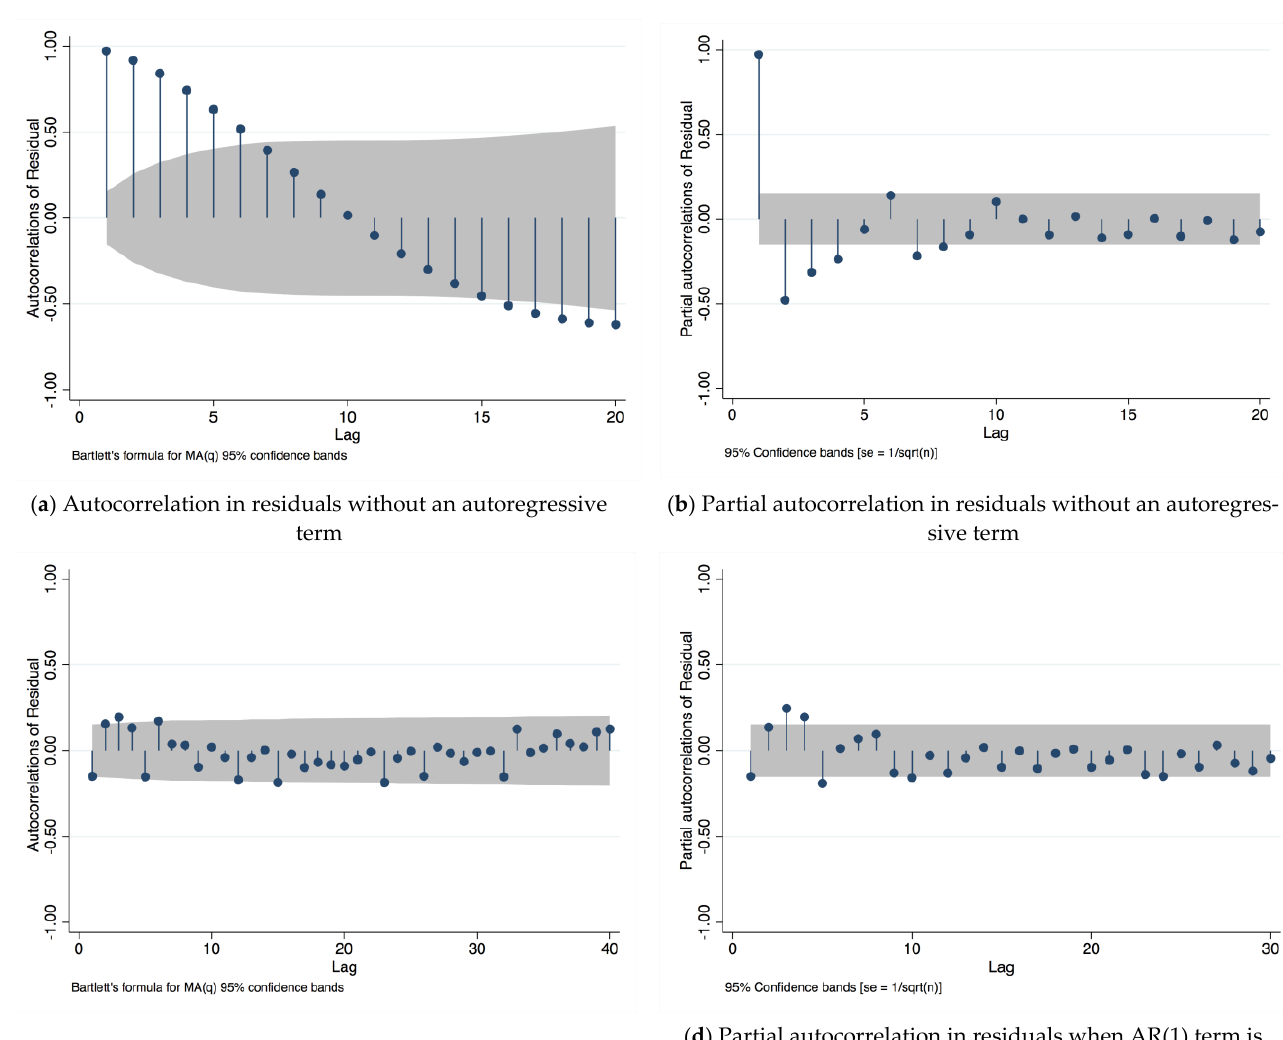
Figure 8. Analysis of autocorrelation in residuals